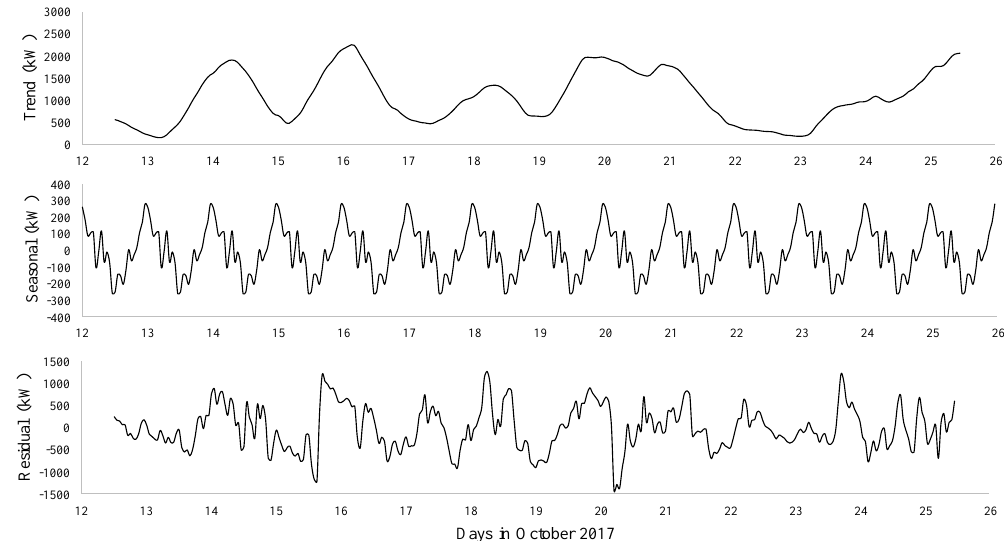
Figure 6. Wind turbine hourly output decomposition.